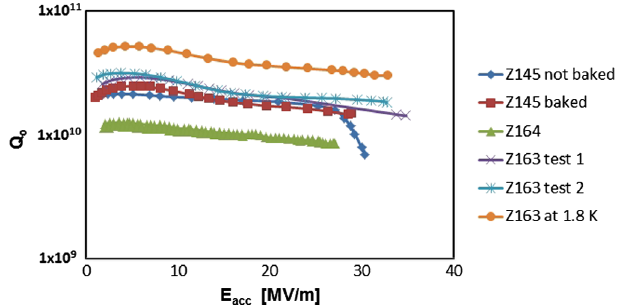
FIG. 36. Radio-frequency performance of nine-cell hydro- formed cavities Z145, Z163 and